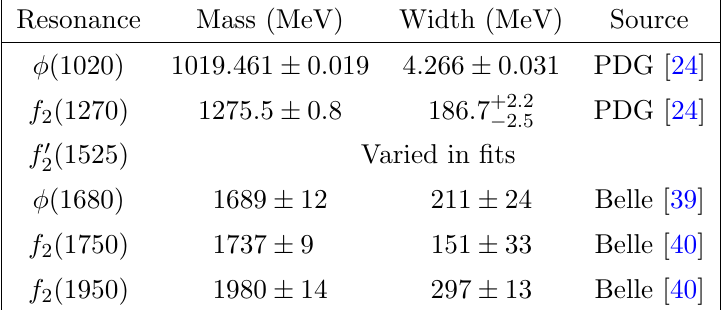
Table 1 . Breit-Wigner resonance